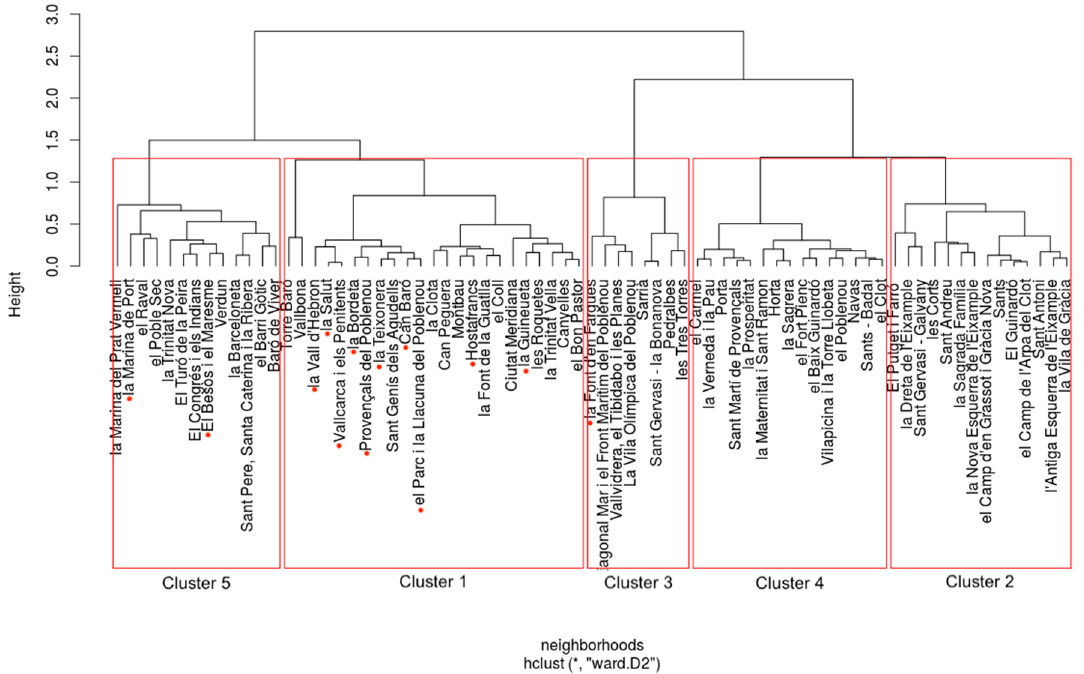
Figure 4. Robustness check dendrogram using Ward clustering.